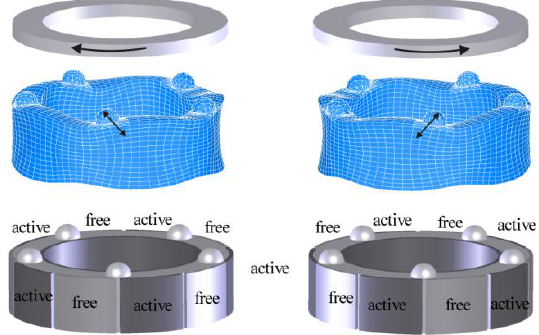
Figure 7. Principle of single mode excitation type resonance (ultrasonic) motor using a cylindrical piezoelectric element developed at PI [22].